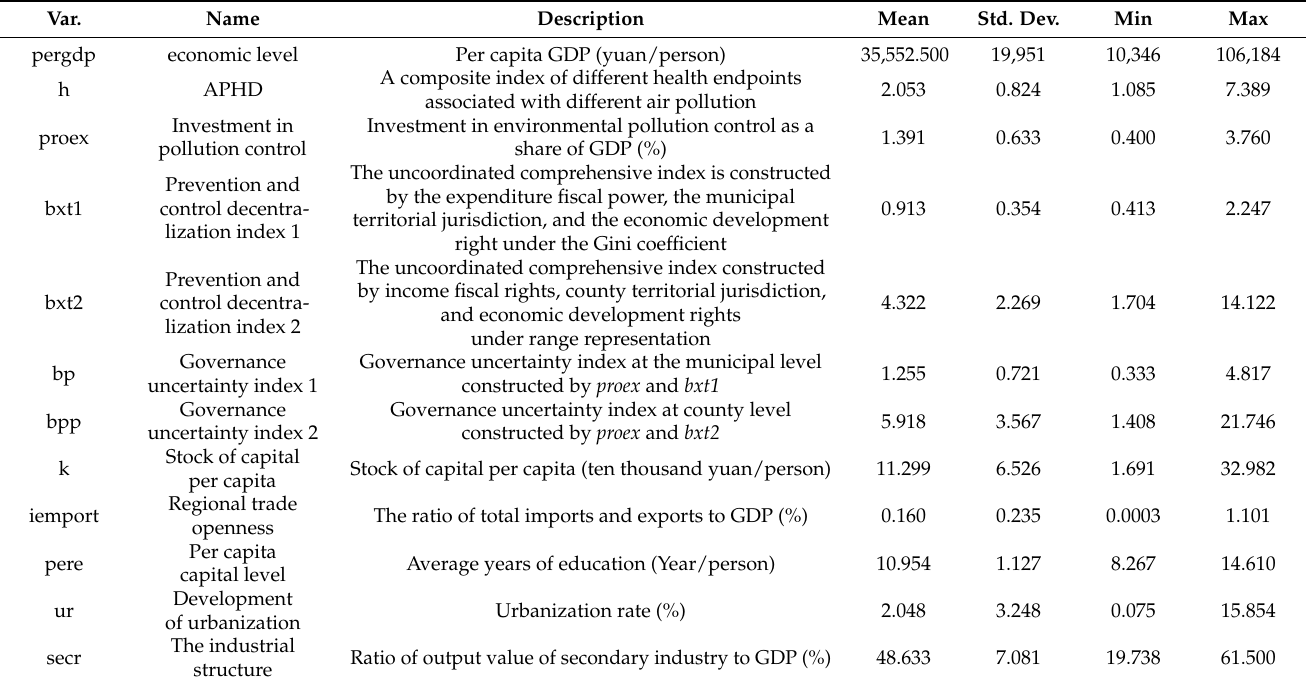
Table 1. The descriptive statistics of the